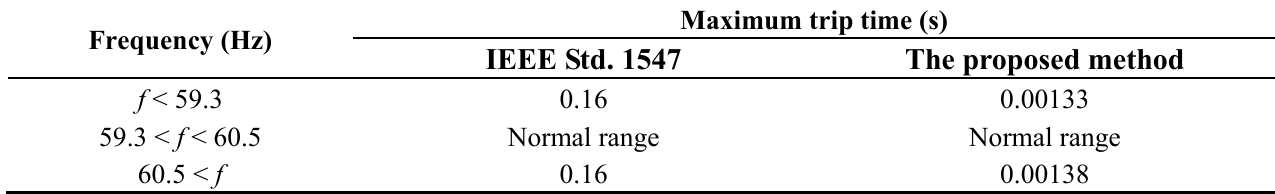
Table 2. The IEEE Std. 1547 and specifications of the proposed method for islanding frequency